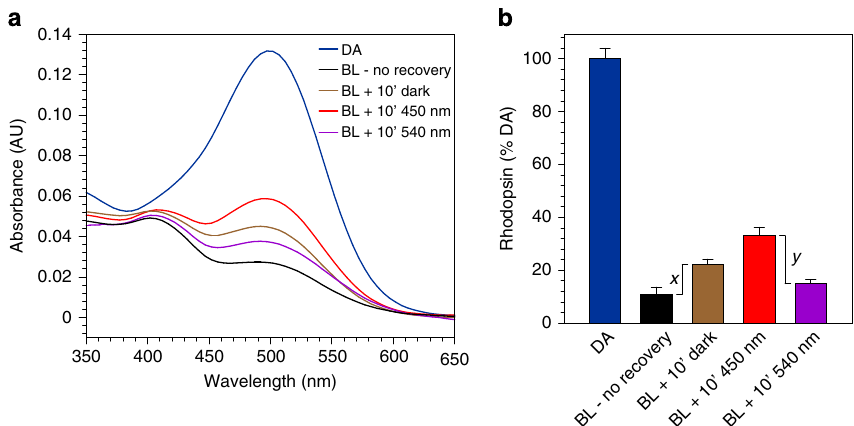
Fig. 4 Light dependent regeneration of rhodopsin in live mice. Wild-type mice were dark adapted overnight and exposed to the following light conditions: dark-adapted (DA); 90% strobe bleach with no recovery time (BL – no recovery); strobe bleach with 10 min recovery in the dark (BL + 10 ’ dark); strobe bleach with 10 min recovery in 450-nm light (BL + 10 ’ 450 nm); or strobe bleach with 10 min recovery in 540-nm light (BL + 540 nm). The photon fl uxes of the 450-nm and 540-nm light were identical. The mice were euthanized, their retinas collected, and af fi nity puri fi cation of rhodopsin was carried out on the retina homogenates. a Representative baseline-normalized UV-Vis spectra of puri fi ed rhodopsin from mice exposed to the indicated light conditions. b Levels of rhodopsin visual pigment in retinas from mice exposed to the indicated light conditions, expressed as percent of dark-adapted rhodopsin. The value x represents the increase in rhodopsin during post-bleach recovery. The value y represents the difference in rhodopsin between mice exposed to 450-nm versus 540-nm light during recovery. Error bars show ± s.d. (n =